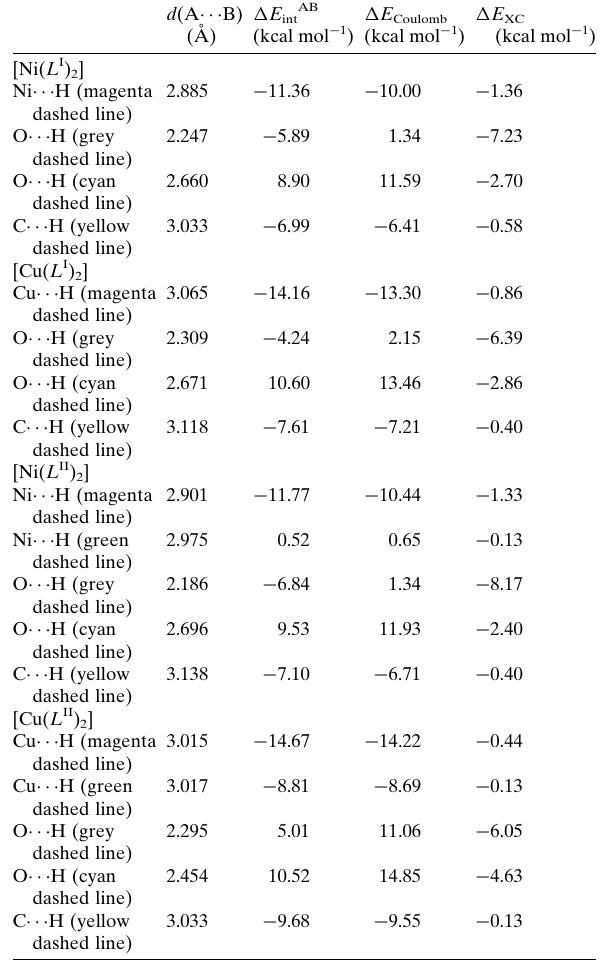
Table 4 IQA energy decomposition of the selected diatomic interactions obtained at the MP2/6-311 + G(d,p) level of theory for the crystal monomers of [Ni( L I,II ) 2 ] and [Cu( L I,II ) 2 ]. (cid:2) E int = (cid:2) E Coulomb + (cid:2) E XC , where (cid:2) E int is the overall diatomic interaction energy, (cid:2) E Coulomb is the Coulomb constituent and (cid:2) E XC is the exchange- correlation contribution (Blanco et al. , 2005).